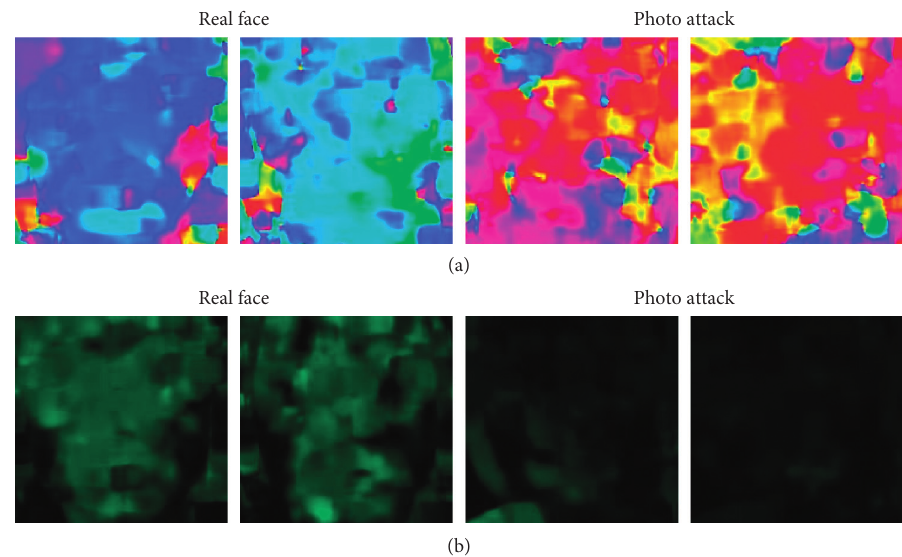
Figure 6: Optical flow visualization of two adjacent face regions: (a) visualization of changes in optical flow direction: hue � direction of optical flow, saturation � 255, and value � 255; (b) optical flow magnitude visualize: hue � 255, saturation � 255, and value � size of optical flow. Among them, the left two are the optical flow changes in the real face, and the right two groups are the optical flow changes in the photo attacks.